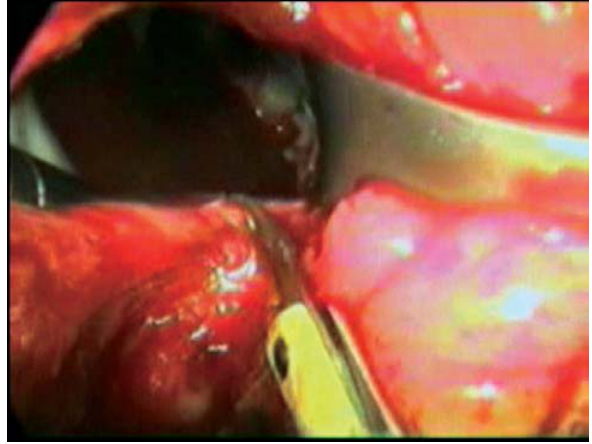
Fig. 2 - Atriotomia esquerda com a cavidade atrial afastada com afastador